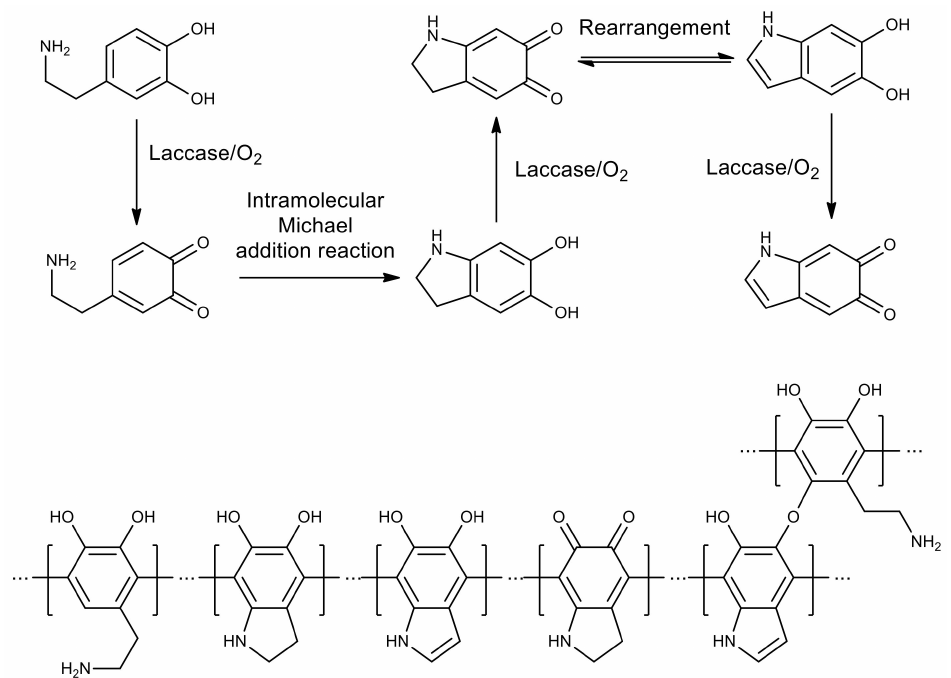
Figure 2. Scheme of the formation of monomers during the oxidation of dopamine with molecular oxygen in the presence of laccase and the structure of the polymer chain of polydopamine, which includes several types of monomer units and additional ether bonds between the chains.